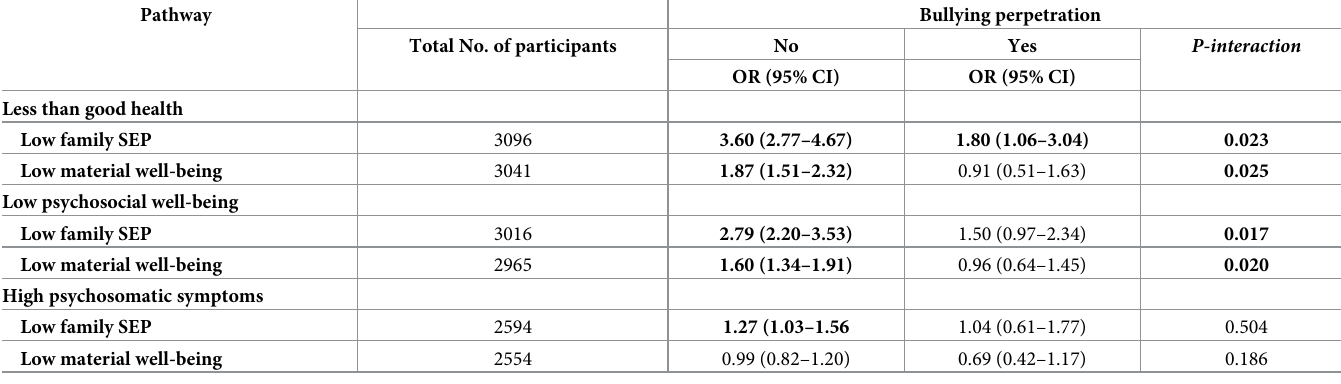
Table 3. Odds ratios (95% confidence interval) of poor health outcomes by two SES measures, adjusted for age, sex, and bullying victimization, stratified by bullying